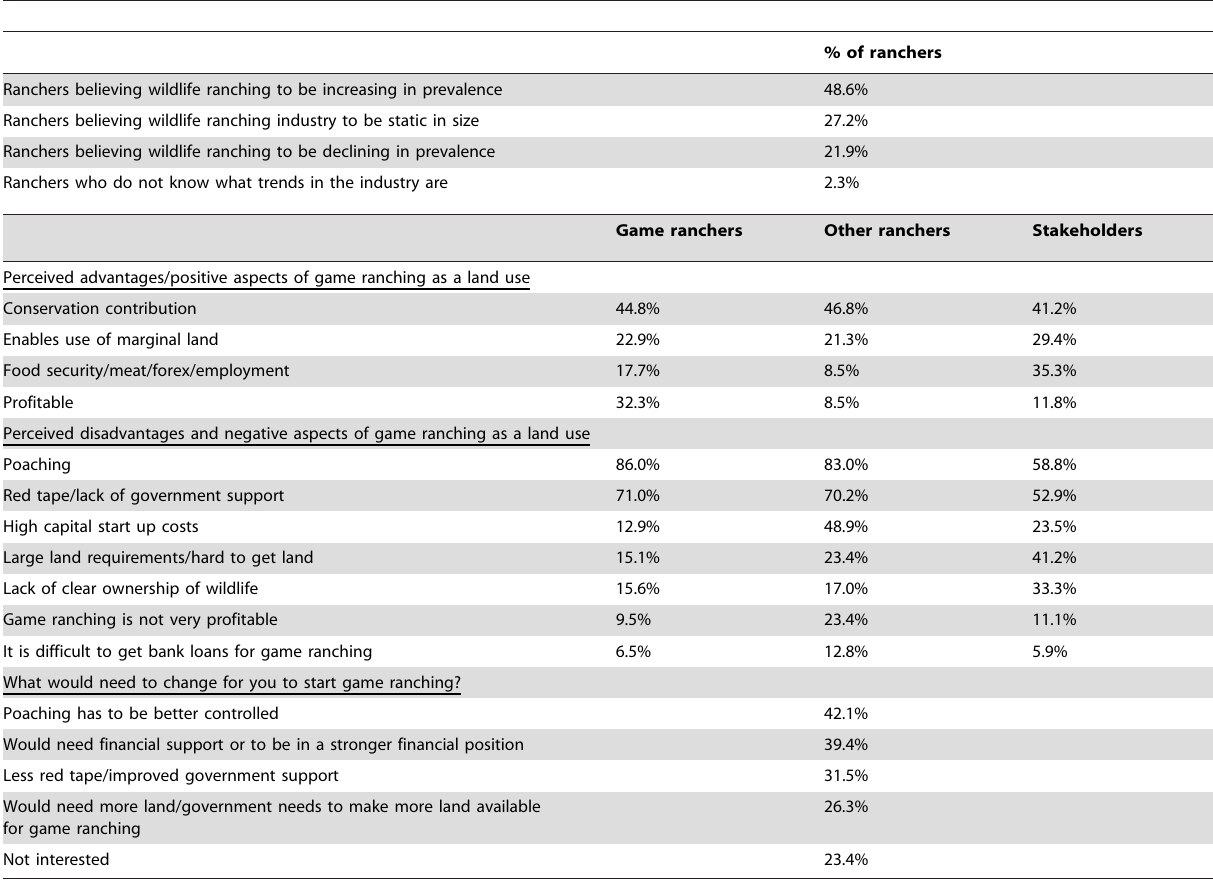
Table 1. Perceived positives and negatives associated with game ranching as a land use, and perceptions on what would have to change for non-game ranchers to engage in wildlife-based land uses.